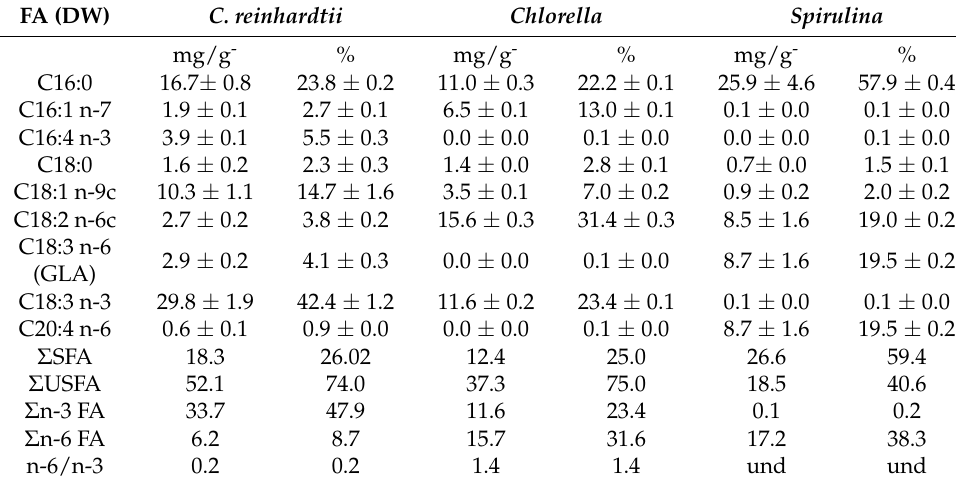
Table 2. Fatty acid (FA) profile of C. reinhardtii , Spirulina and Chlorella . FA (DW) C. reinhardtii Chlorella